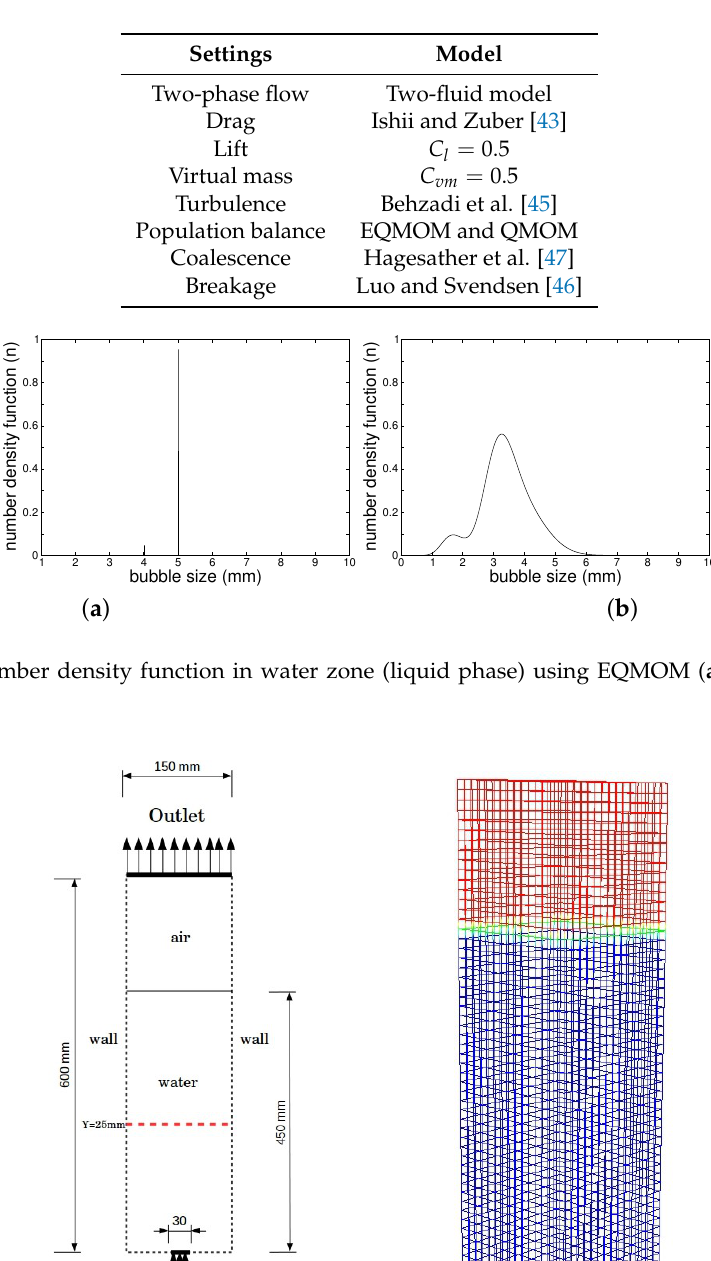
Table 13. Overview of the models used in the solver.